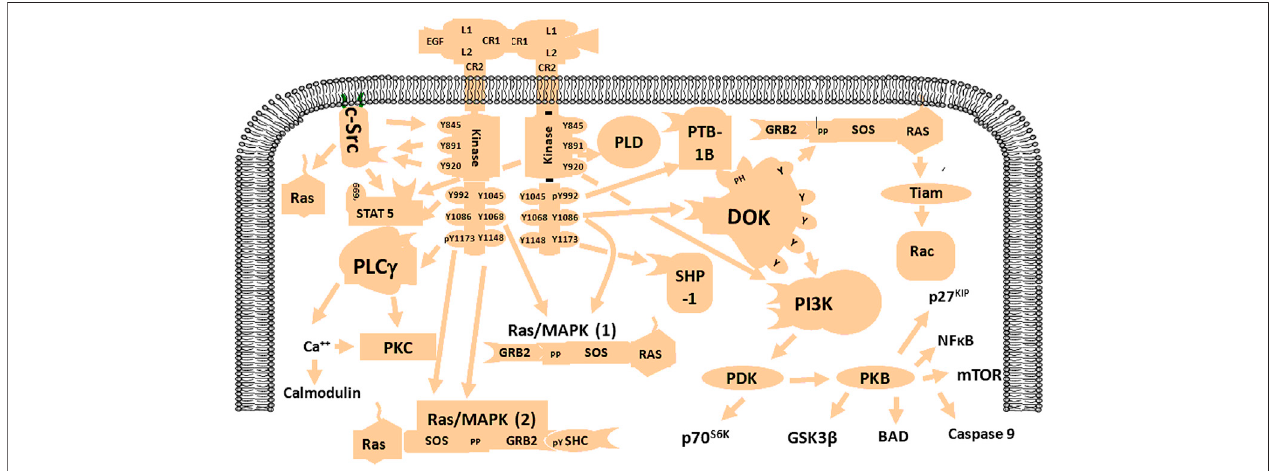
FIGURE 1 | Schematic diagram of the EGFR signaling network. EGFR is activated by speci fi c factors that induce different signaling pathways such as PI3K/Akt, Ras/MAPK, NF-kB, and mTOR with various biological functions including enhancement of proliferation, invasion, angiogenesis, and resistance to